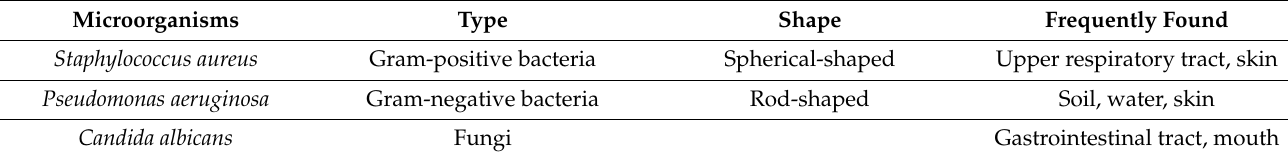
Table 3. Basic characteristics of the